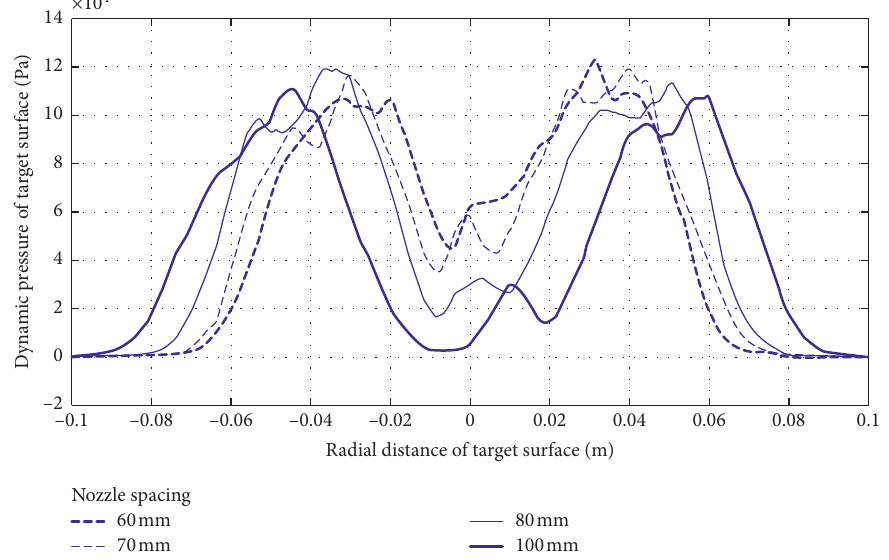
Figure 16: Radial dynamic pressure of target surface at different